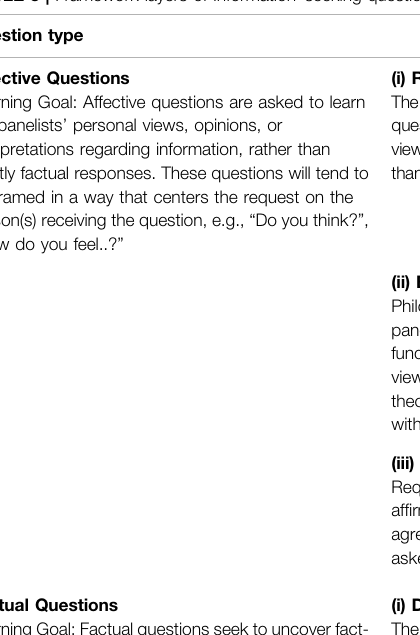
TABLE 3 | Framework layers of Information – seeking question types, subtypes, and